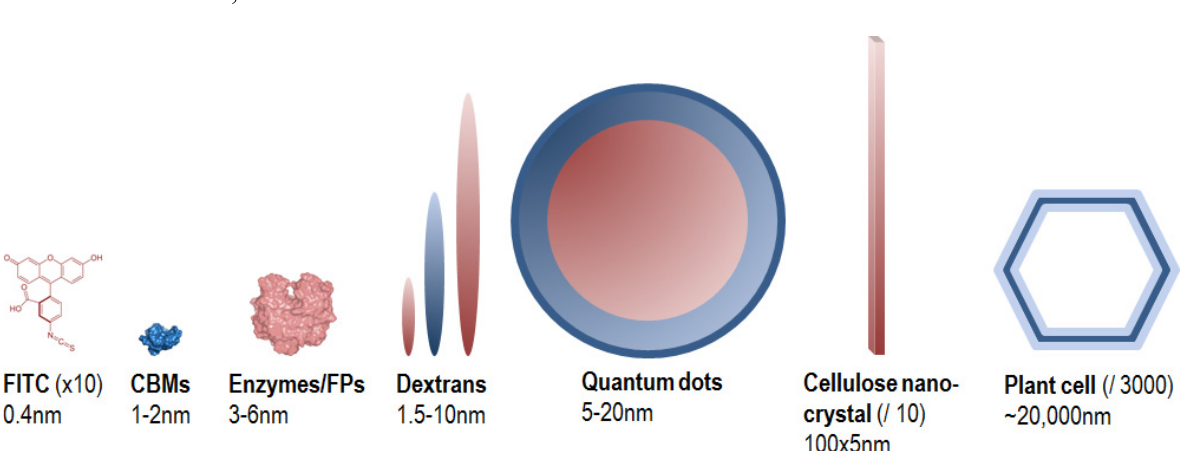
Figure 4. Size comparison of fluorophores, probes and PCW elements. Because of large size differences, the PCW elements are not at the same